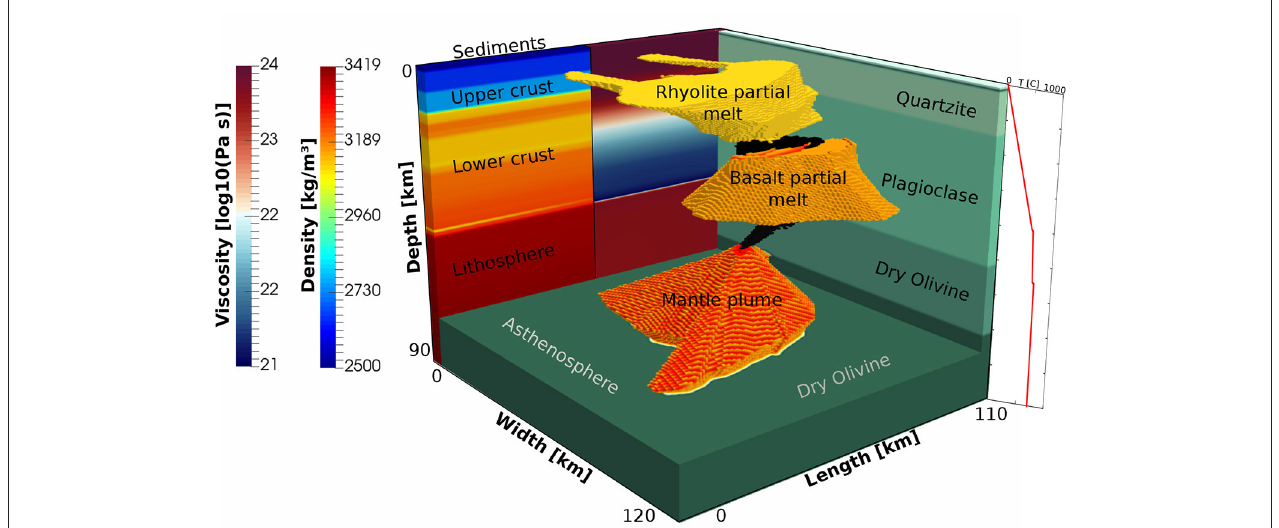
FIGURE 2 | Model setup of the computational domain representing the lithospheric scale Yellowstone magmatic system. The positions and shapes of the phases are inspired by the seismic tomography data shown in Huang et al. (2015). Chambers and mantle plume are connected, while these connections can be active or made inactive (by giving it the same material properties as the host rock). Colors at the back of the domain show the density (left side) and viscosities (right side) at this location, while temperature along a 1D profile through the middle of the domain is shown at the right.